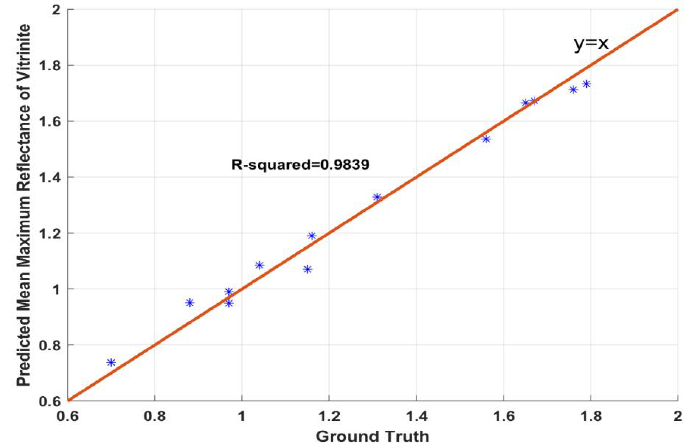
Figure 8. Correlation chart of mean maximum vitrinite reflectance values measured by MMVRML and the traditional method.